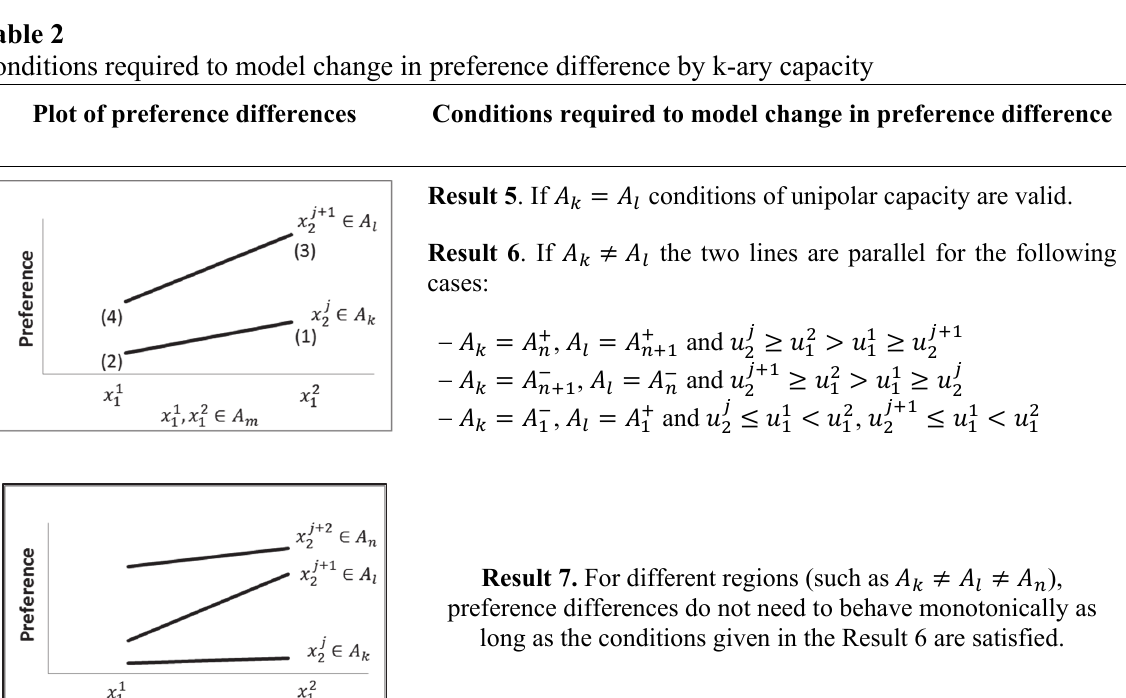
Result 7. For different regions (such as 𝐴 preference differences do not need to behave monotonically as long as the conditions given in the Result 6 are